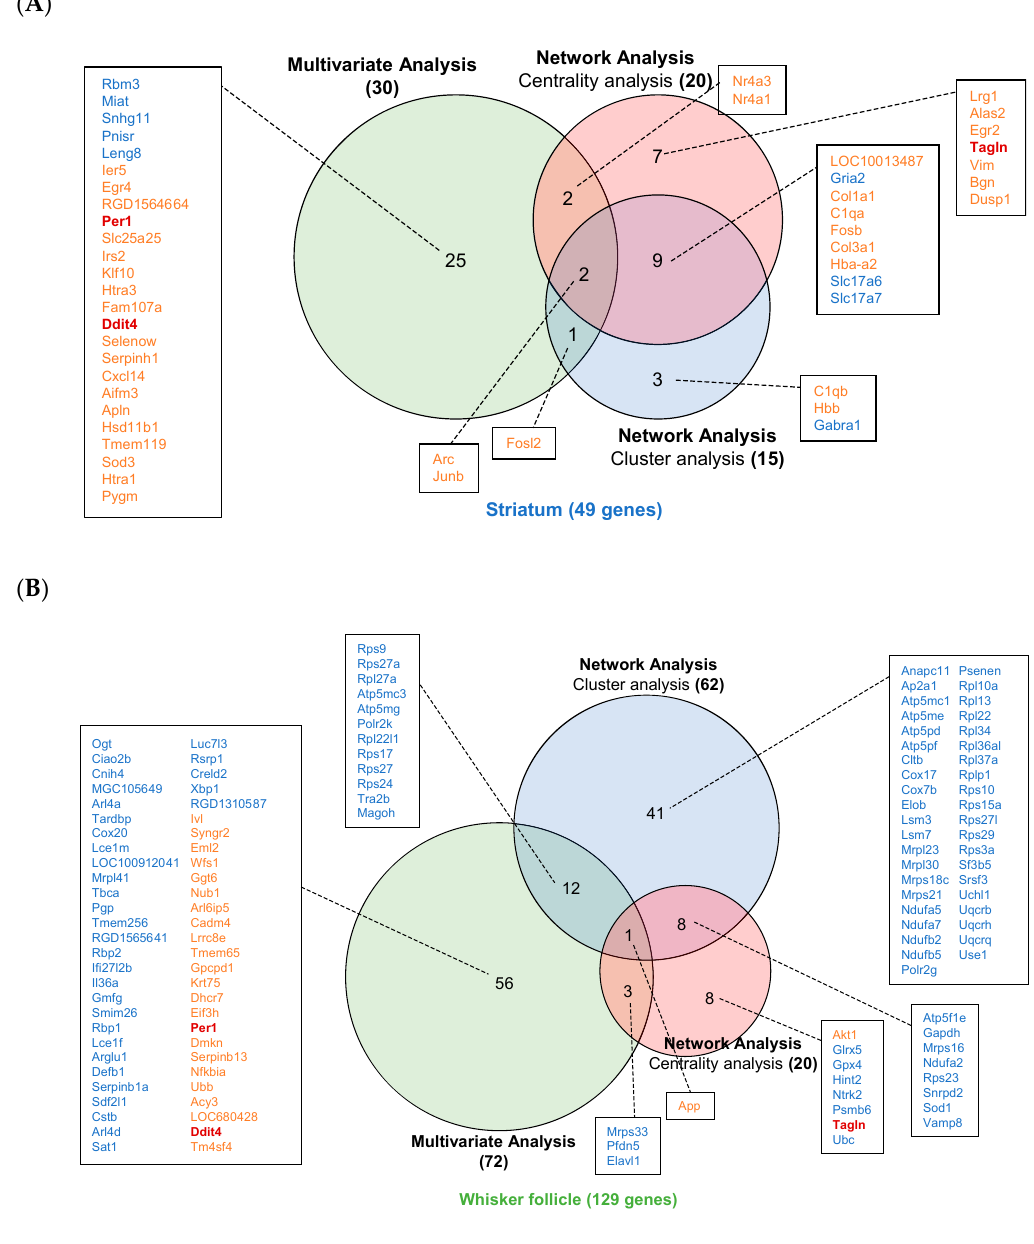
Figure 7. Potential diagnostic markers identified in the striatum ( A ) and in whisker follicles ( B ) of methamphetamine (MA) self-administered rats. The Venn diagram shows the potential markers identified by the multivariate and network analyses. Orange color: genes increased by MA, Blue color: genes decreased by MA, Red boldfaced: The genes identified both in the striatum and in whisker follicles.